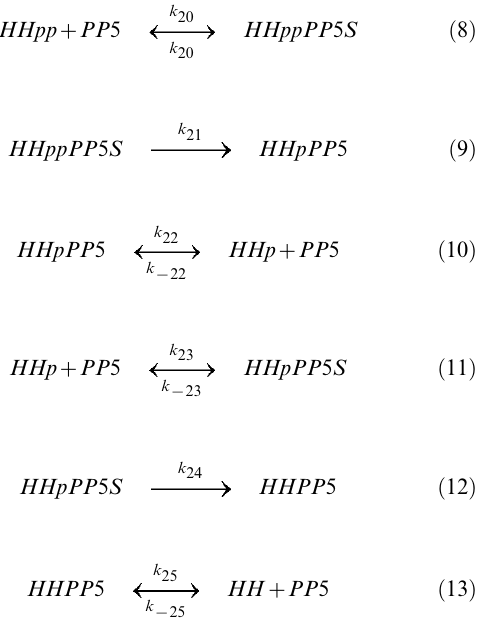
Y | 100 , for Y max